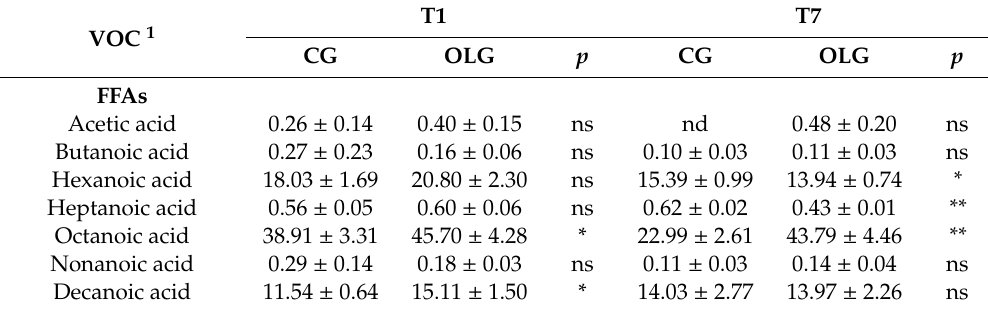
Figure 2. Schematic representation of relative proportions (%) of volatile compound families detected in yogurt samples obtained from goats fed the standard diet (CG) and goat that received the dietary supplementation with olive leaves (OLG). Samples were analyzed after 1 day (T1) and 7 days of storage (T7) at 4 °C. Free fatty acids (FFAs). Table 2. Volatile compounds (VOC) identified in yogurt samples obtained from goats fed a standard diet (CG) and goats fed a dietary supplementation of olive leaves (OLG). Samples were analyzed after 1 day (T1) and 7 days of storage (T7) at 4 ◦